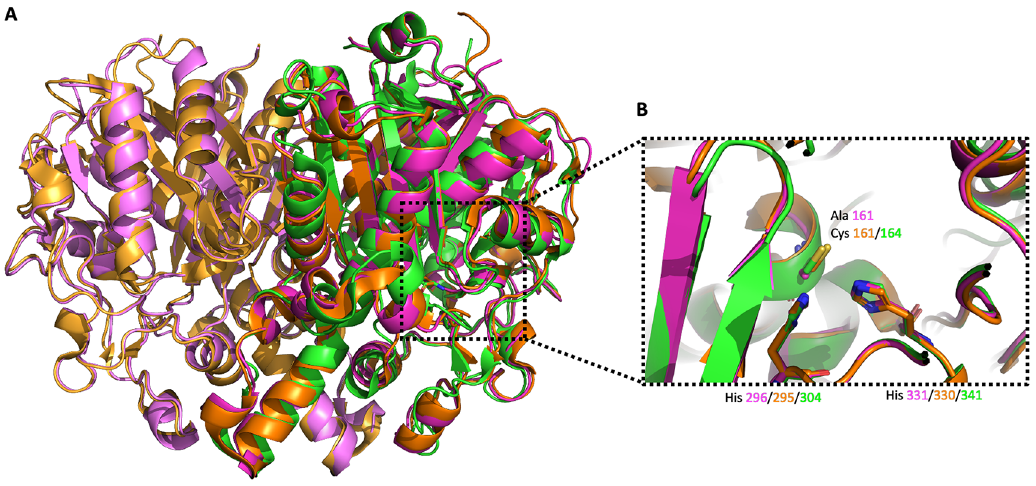
Figure 6. Alignment of Vc FabB (PDB Id 4XOX) dimer, Pa FabF (4JPF) monomer and Pa FabB C161A (7PPS) dimer. A) The three different enzymes are shown in orange/light orange, green and magenta/light magenta cartoon style, respectively. B) Alignment of the active site catalytic triad of Vc FabB, w. t. Pa FabF and Pa FabB C161A.